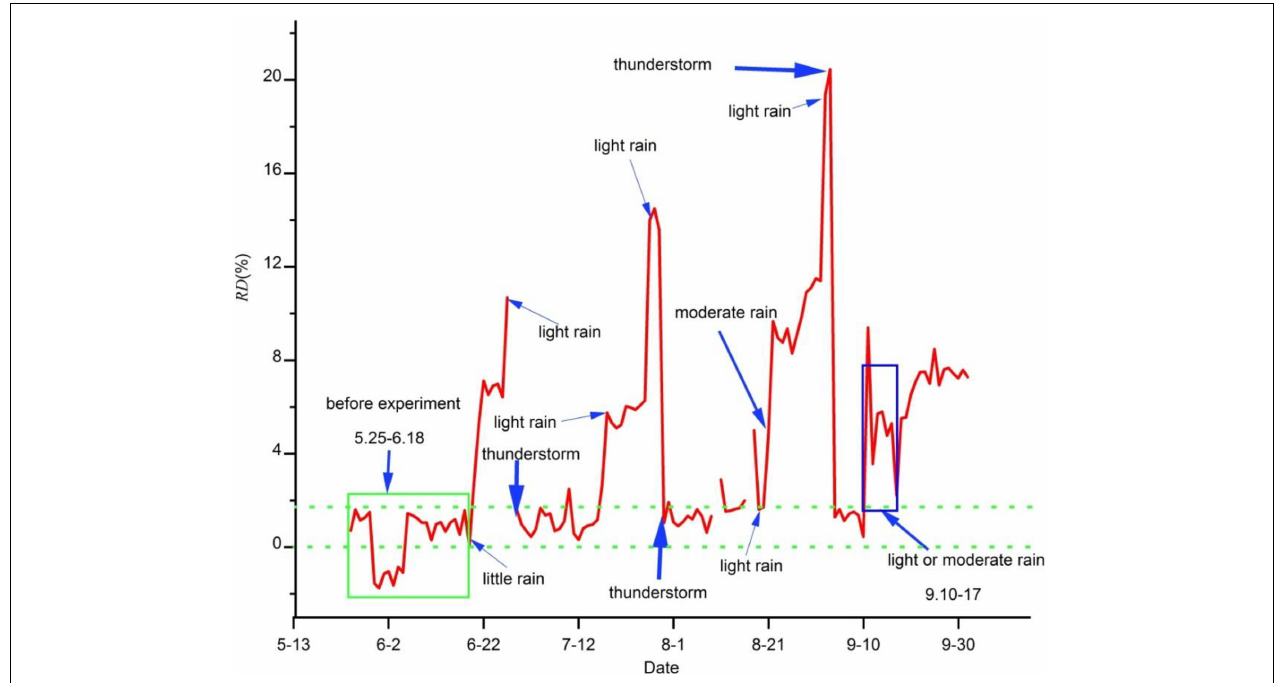
FIGURE 4 | Relative differences (RDs) between the daily maximum current of MPPT one (I mc ) and MPPT two (I ms